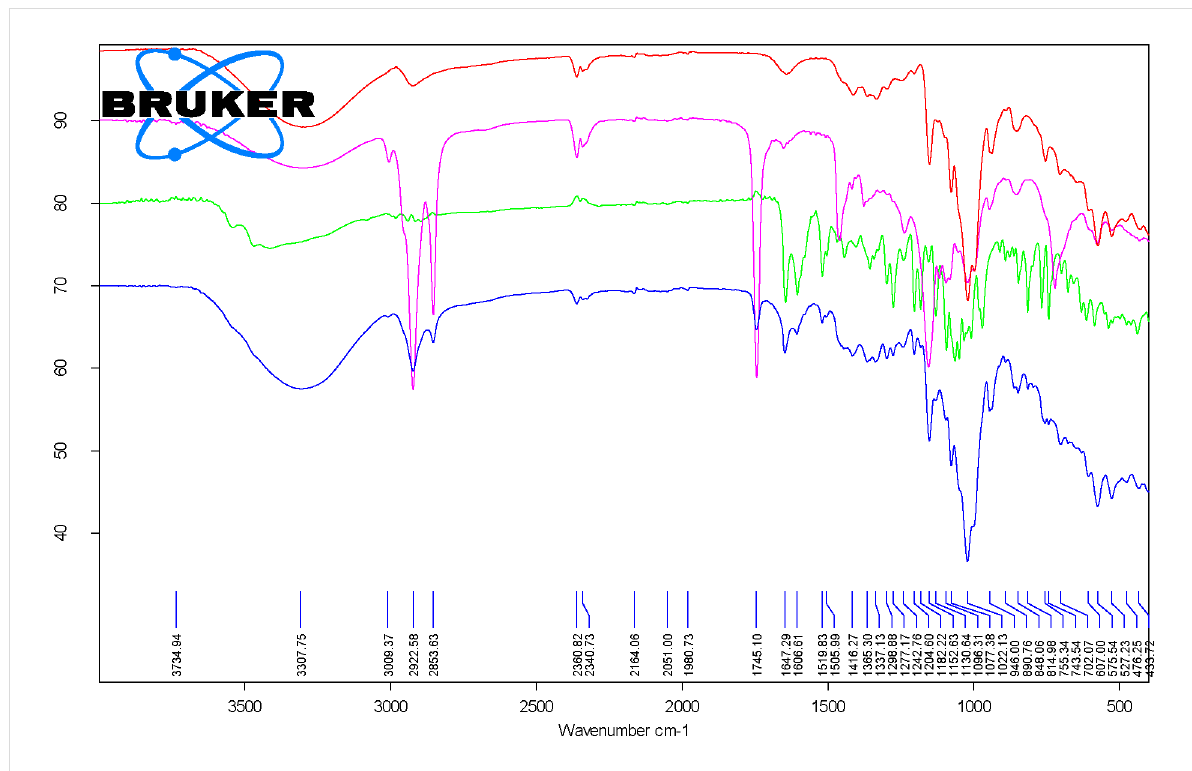
Figure 3: Superposition of the FTIR spectra for the β -cyclodextrin/ Corylus avellana oil/hesperidin ternary complex at a 3:1:1 molar ratio (blue), β -cyclodextrin hydrate (red), C. avellana oil (pink), and hesperidin (green).